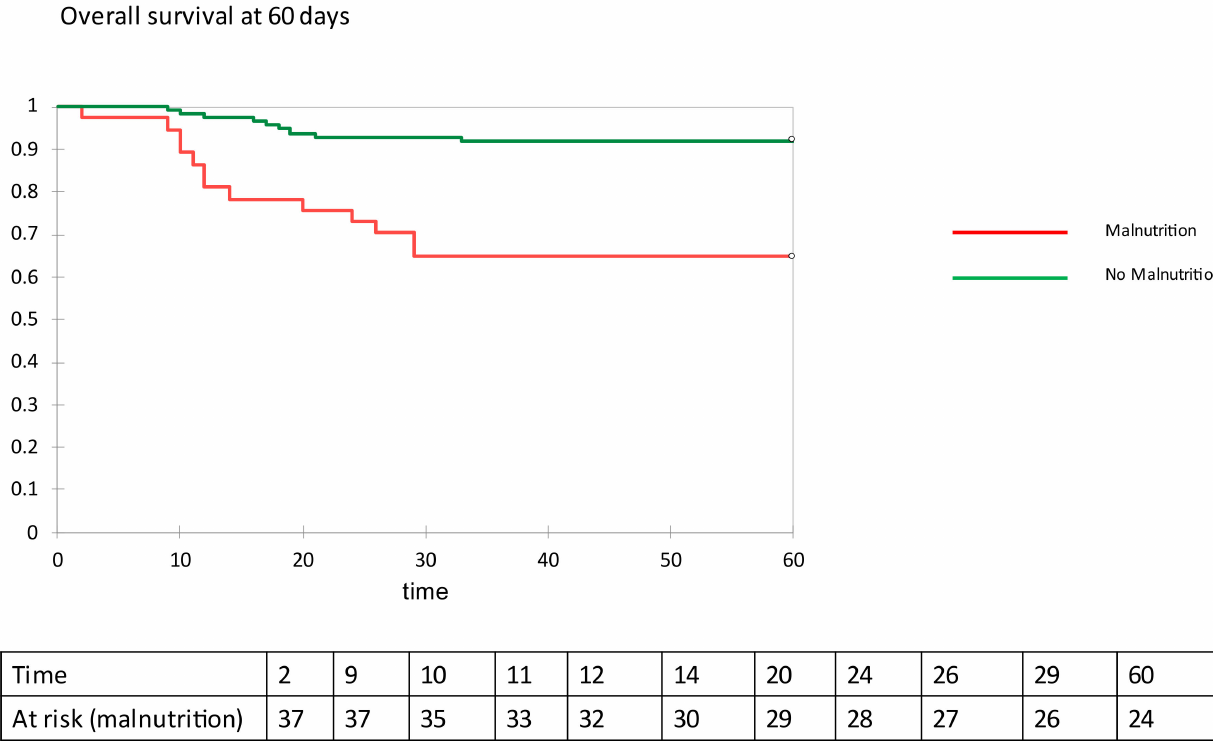
Figure 3. Overall survival at 60